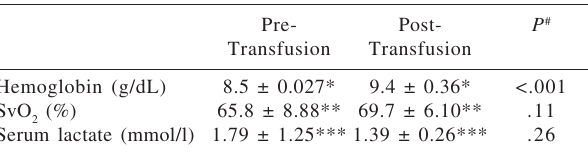
oxygen saturation Table 4 - Hemoglobin, mixed venous oxygen saturation and serum lactate pre and post-transfusion in the subgroup with hemoglobin < 8g/dL Pre-